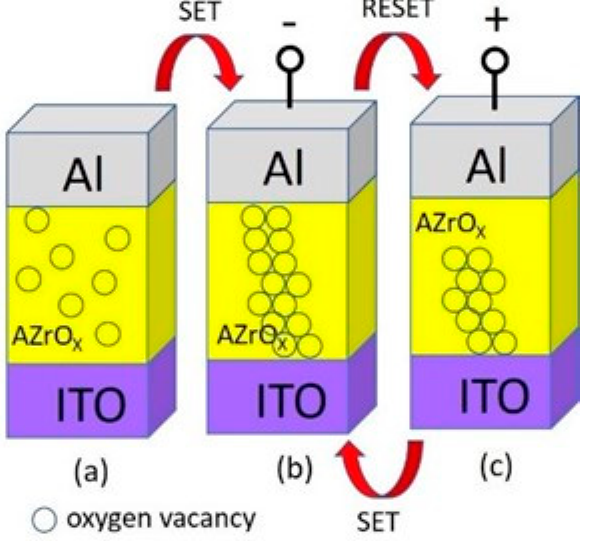
Figure 8. Model of the resistance switching mechanism. ( a ) pristine, ( b ) LRS, and ( c ) HRS condi- tions.